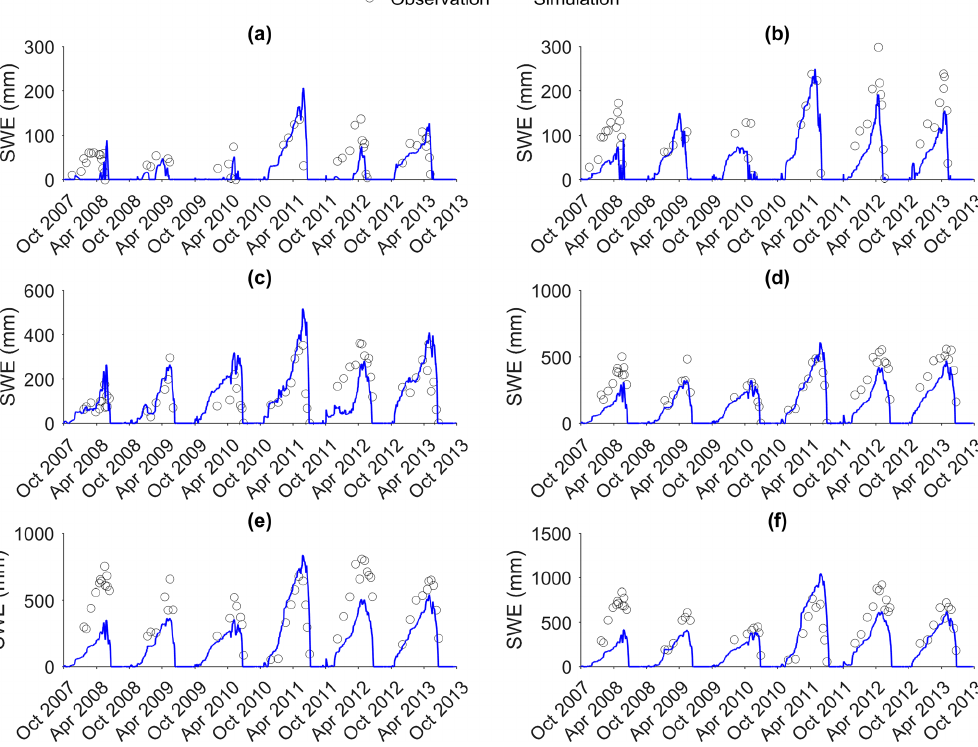
Figure 4. Comparison of the observed and simulated snow accumulation (SWE) for 2007–2013 at the sheltered, mid-elevation Upper Forest/Clearing and wind-blown, high-elevation Fisera Ridge sites in MCRB. (a) Mature spruce forest, (b) forest clearing, (c) ridge top, (d) upper alpine south-facing slope, (e) lower upper alpine south-facing slope, and (f) larch forest treeline.